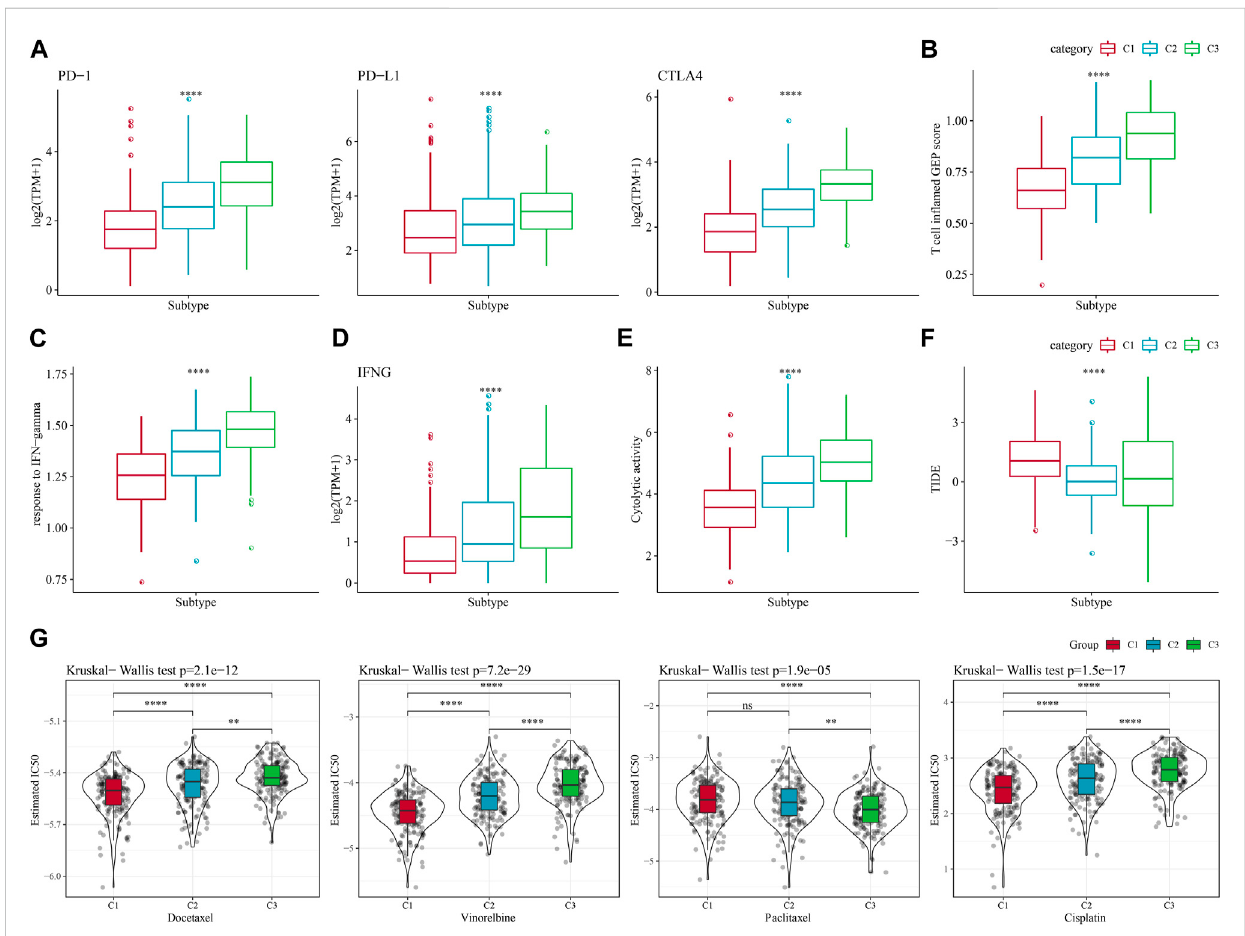
FIGURE 5 Differences in immunotherapy/chemotherapy treatment between molecular subtypes. (A) Differences in expression of immune checkpoint genes between molecular subtypes. (B) difference in “ T cell in fl amed GEP score ” between molecular subtypes. (C) Differences in “ response to IFN-gamma ” between different molecular subtypes. (D) Differences in INFG gene expression in different isoforms. (E) Differences in “ Cytolytic activity ” between different molecular subtypes. (F) Differences in TIDE scores between subtypes. (G) Box plots of estimated IC50 of docetaxel, vincristine, paclitaxel and cisplatin in